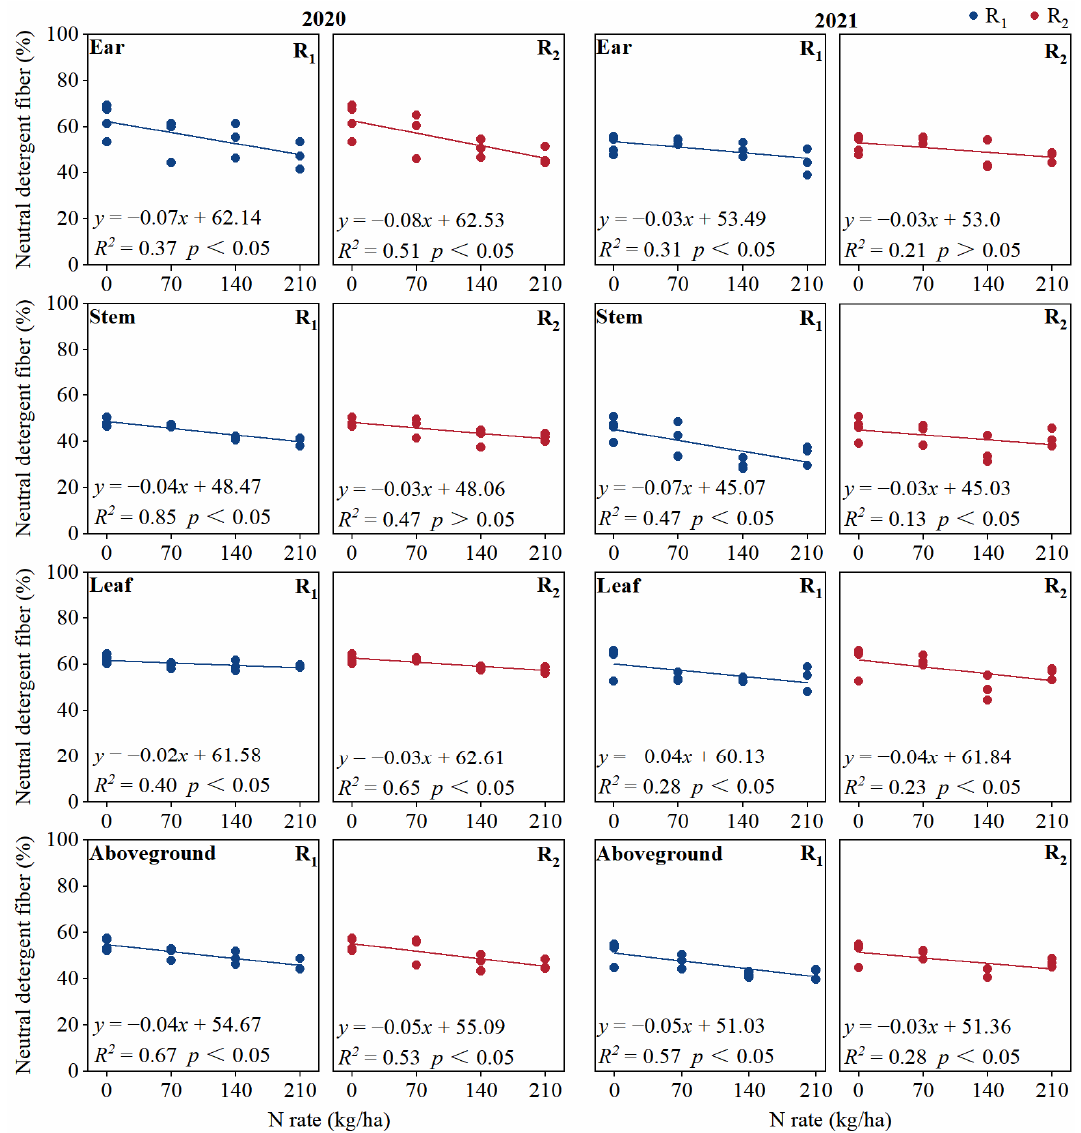
Figure 7. NDF of forage maize at harvest under different treatments in 2020 and 2021.